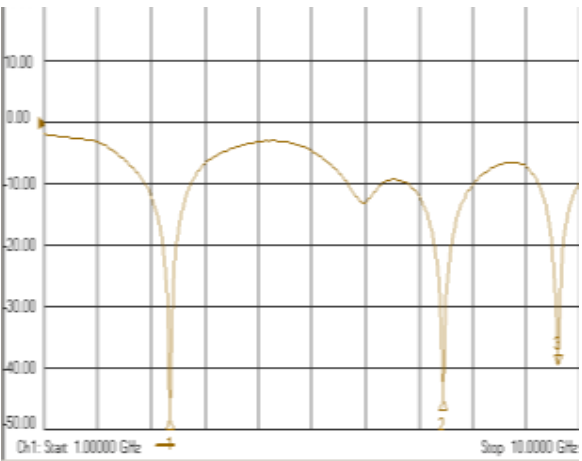
Figure 15: Measured return loss of the proposed